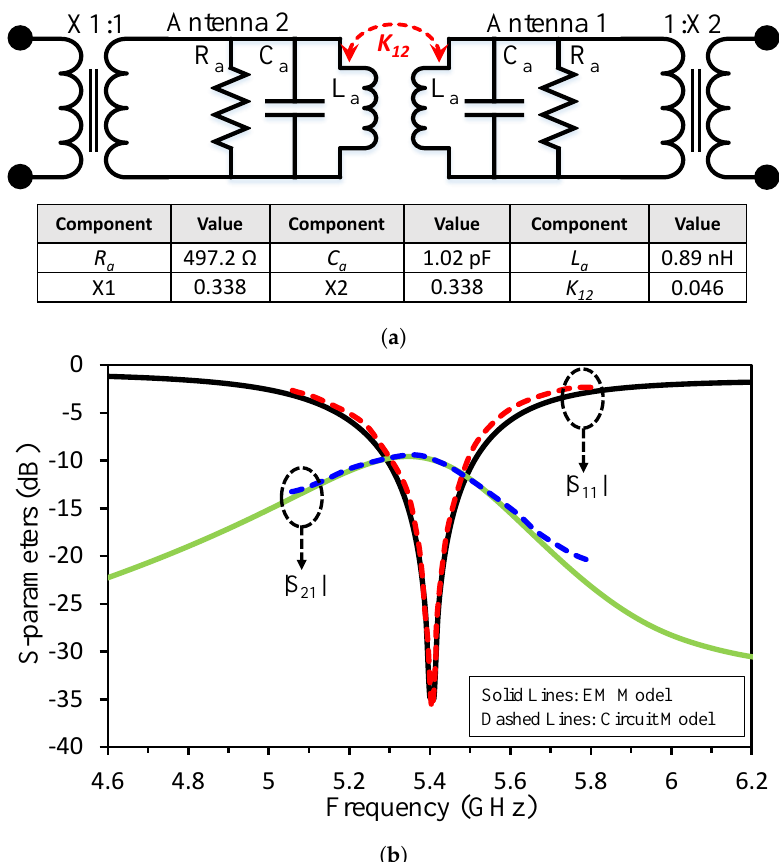
Figure 4. ( a ) Equivalent circuit model of the two-element MIMO antenna without decoupling structure, and ( b ) S-parameters comparison of the EM model (solid lines) and circuit model (dashed lines).